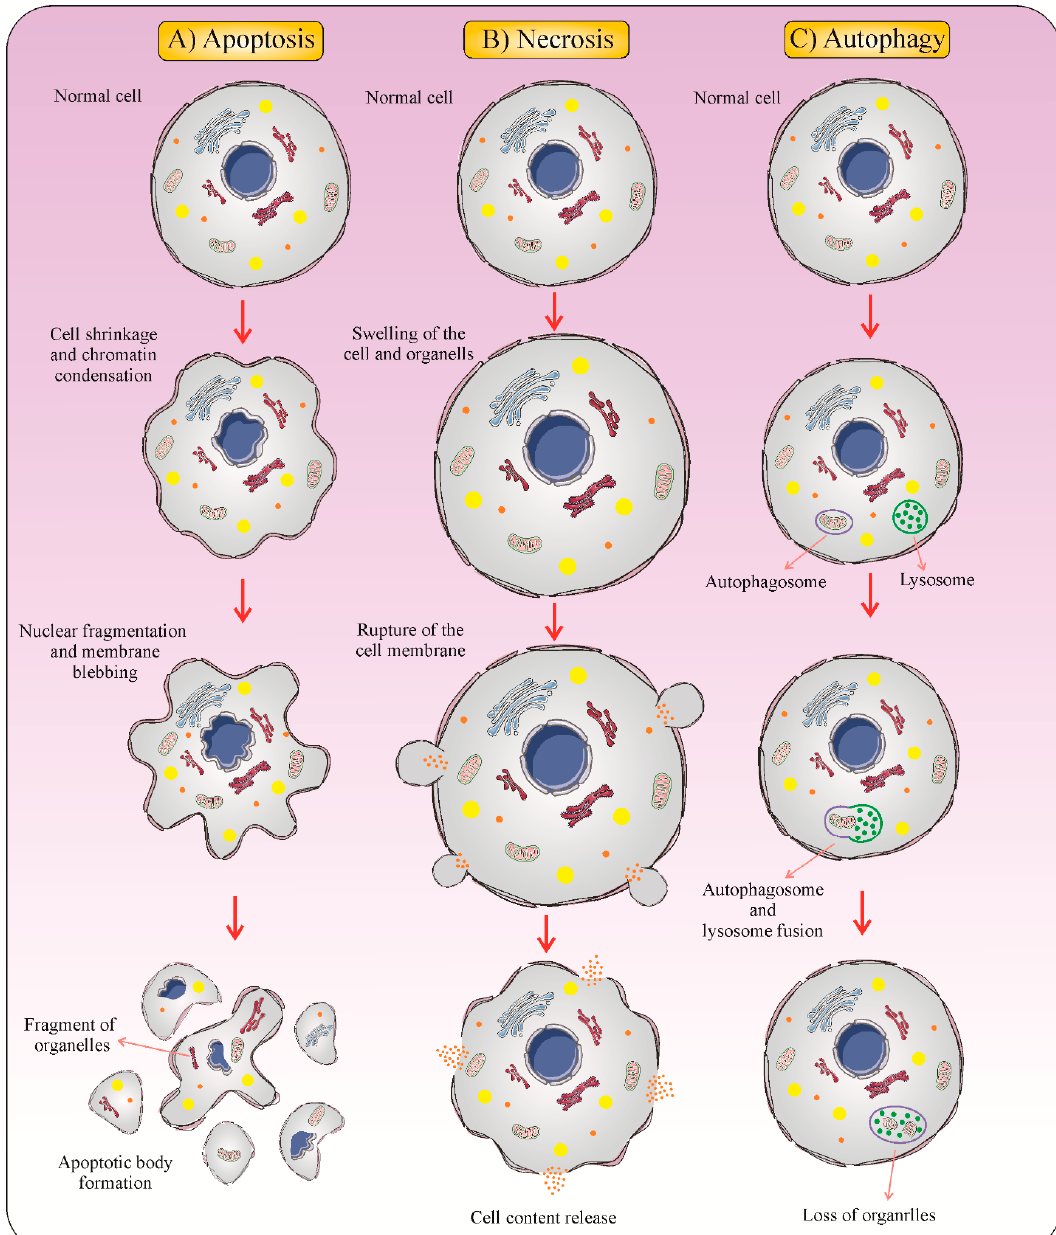
Figure 1. Three different forms of cell death. ( A ) Apoptosis is a form of cell death that some Figure 1. Three di ff erent forms of cell death. ( A ) Apoptosis is a form of cell death that some molecular mechanisms in a cell lead to its death. It is generally characterized by distinct morphological features including cell shrinkage, blebbing, and nuclear fragmentation. ( B ) Necrosis is a type of cell death that is morphologically described by an increasing translucent cytoplasm, swelling of organelles, and increased cell volume. ( C ) Autophagy is the major intracellular degradation process by which cytoplasm ingredients are translocated to and degraded in the